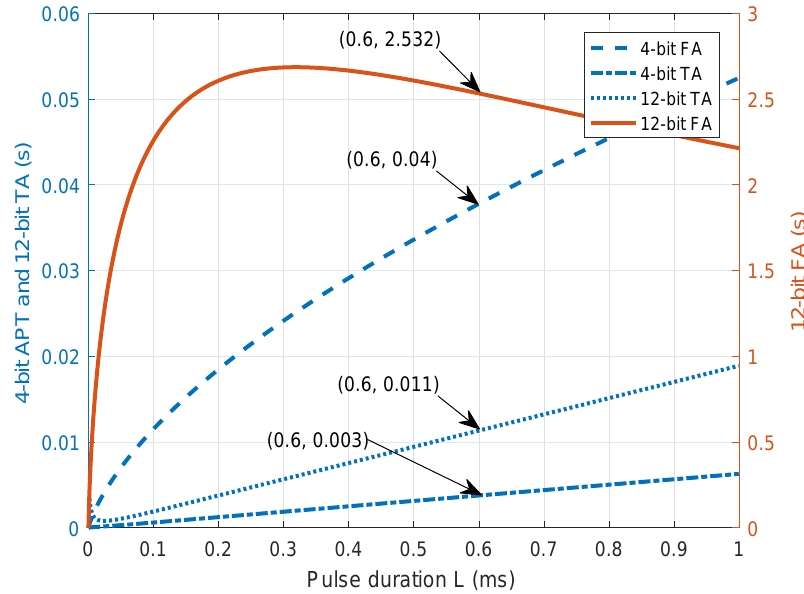
Figure 12. Reduction of the average positioning time (APT) by the use of receiver defined threshold angle (TA) instead of the conventional full angle (FA) in